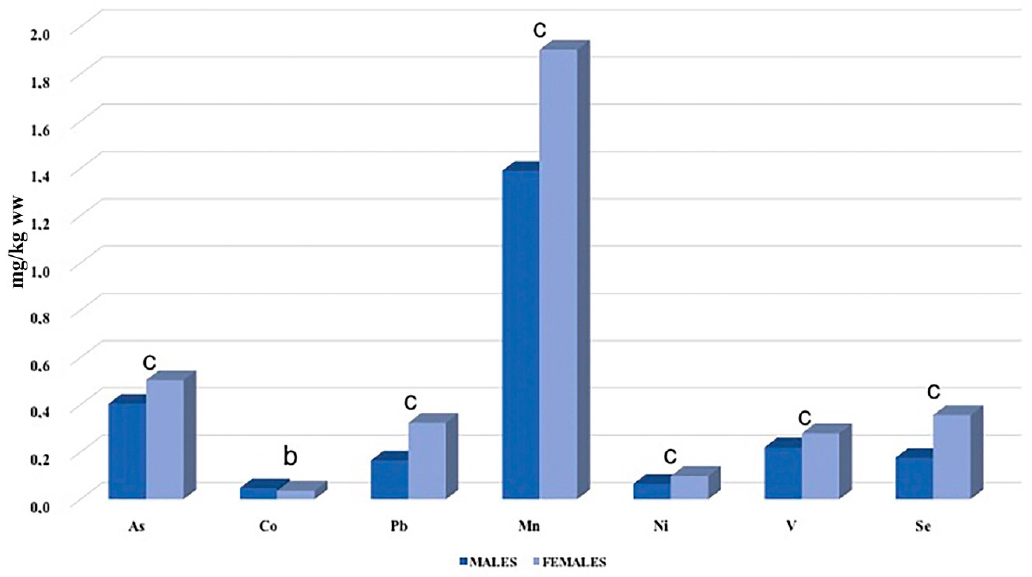
Figure 2. Mean values of metals and metalloids concentrations in gastrointestinal content (mg / kg ww). Significant differences between sex: b, p < 0.01, c: p < 0.05.